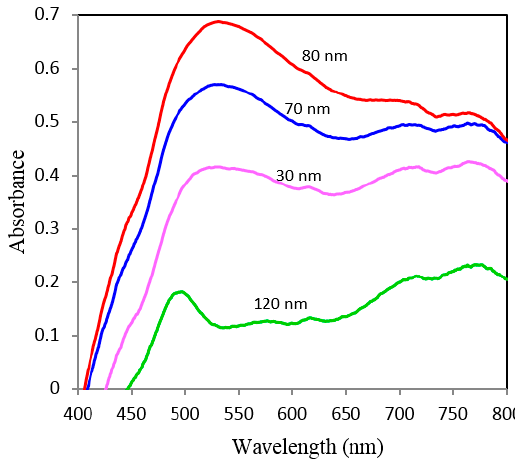
Figure 11. Normalized absorption spectra for 35 nm pore size coated with 70, 80, 90 and 120 nm thick gold films measured at normal incidence.